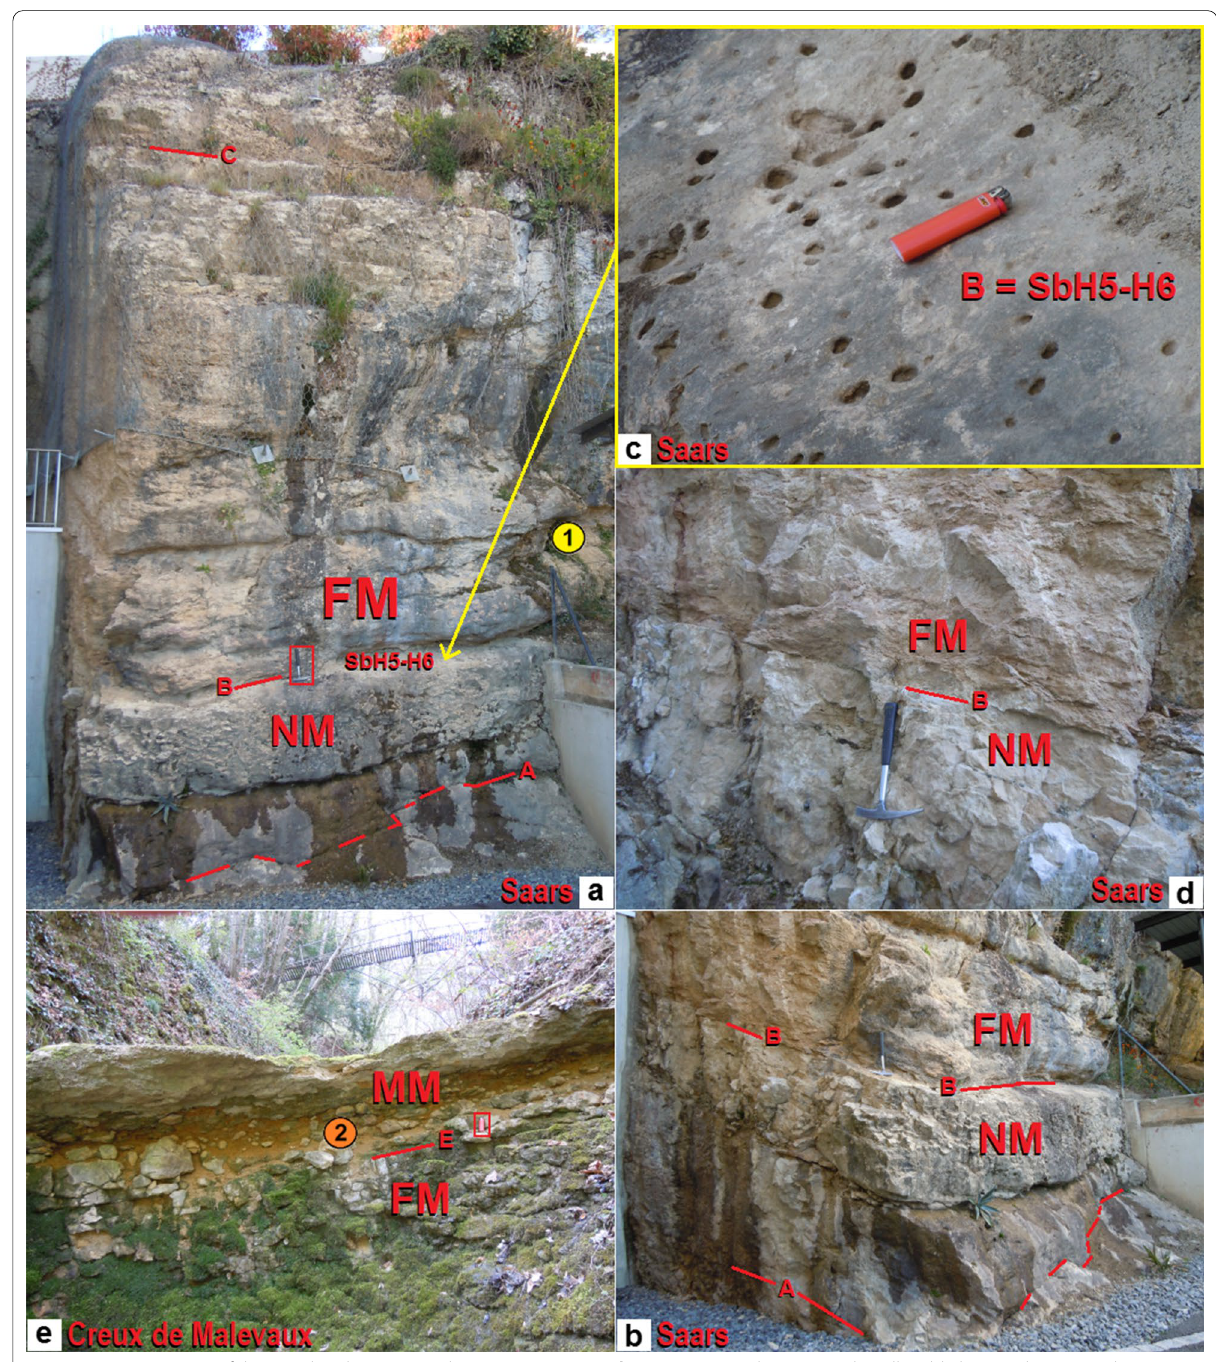
Fig. 4 Saars Formation of the Neuchâtel area (central Jura Mountains). a – d Les Saars‑Le Mail section with well visible lower Falaises Member boundary ( a , b , d ) and deeply bioperforated Late Hauterivian discontinuity surface B ( c ). e Creux de Malevaux section with Early